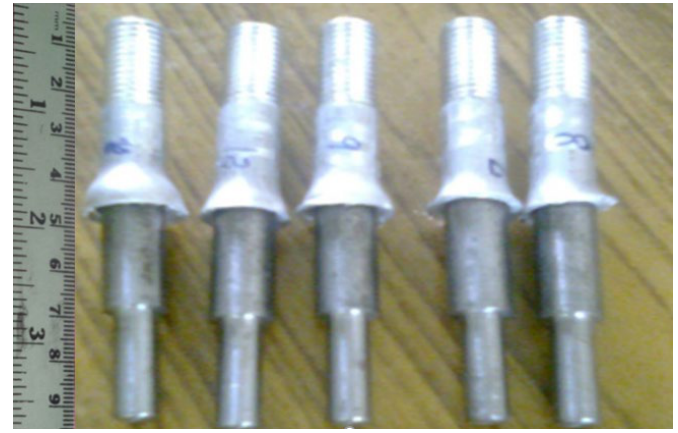
Figure 4. Friction welded AA6061-5% B 4 C/AISI 1030 steel joints.